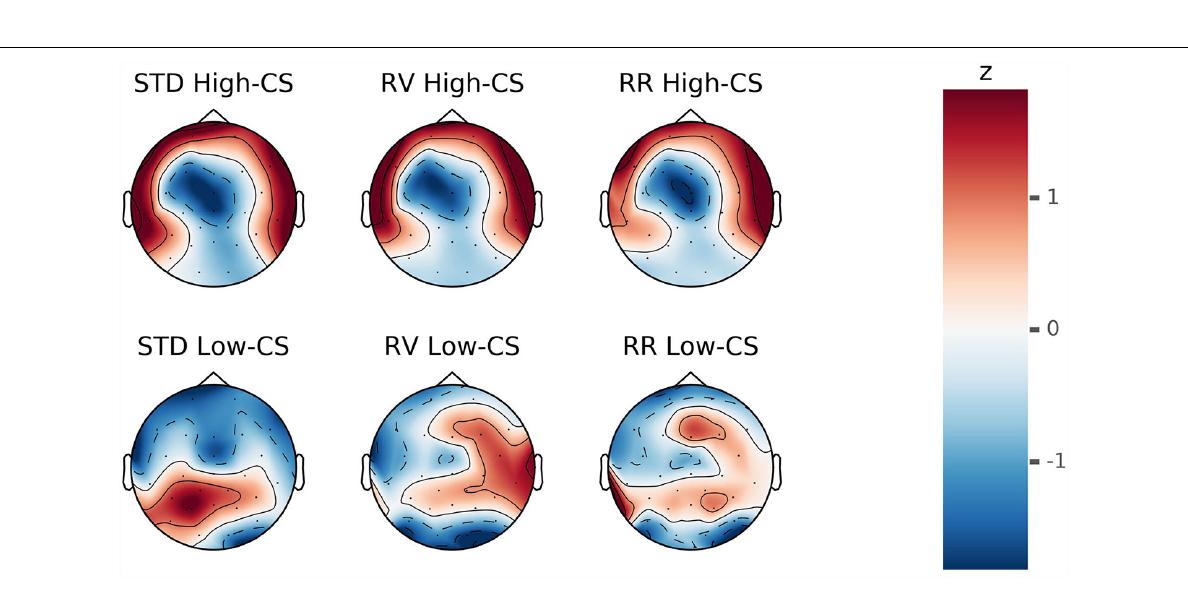
FIGURE 7 | Z-transformed voltage distributions during response-locked ERP after correct responses in a time window of 30–50 ms. The upper and lower heads show distributions of participants scoring high and low on conscientiousness (CS), respectively. The distributions of each group are displayed separately by column for the instruction conditions standard (STD), rule violation (RV) and rule reversal